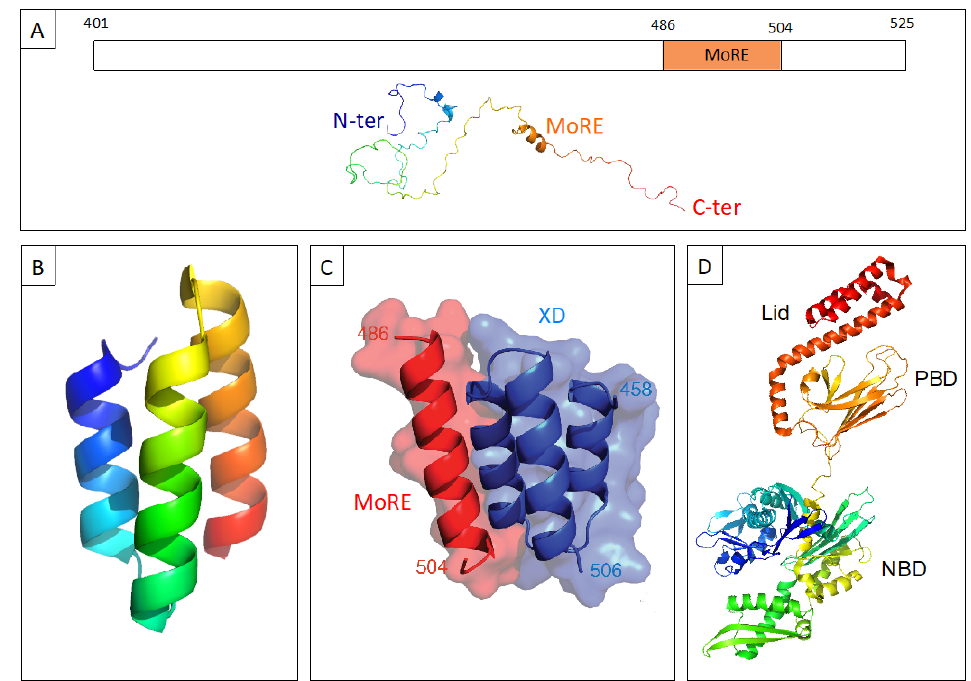
Figure 1. ( A ) Schematic representation of the C-terminal domain of the nucleoprotein (N) of measles virus (MeV) N TAIL (upper panel) and cartoon representation of an N TAIL conformer generated using Flexible-Mecano [49]. ( B ) Ribbon representation of the crystal structure of the C-terminal X domain of the phosphoprotein of MeV XD (PDB code 1OKS). ( C ) The structure of the chimeric construct made of MeV XD (blue) and of the molecular recognition element MoRE of N TAIL (red) (PDB code 1T6O). ( D ) Cartoon representation of the crystal structure of hsp70 based on PDB codes 1HJO and 4JNF. The relative orientation of the two hsp70 domains (i.e., amino acids 3 to 382 and amino acids 389 to 610) is based on the structure of a form encompassing residues 1 to 554 (PDB code 1YUW). The three constituent domains of hsp70, i.e., nucleotide binding domain (NBD, aa 1 to 384), peptide binding domain (PBD, aa 384 to 543) and “lid” (aa 543 to 641) (see [18] and references therein cited) are highlighted.